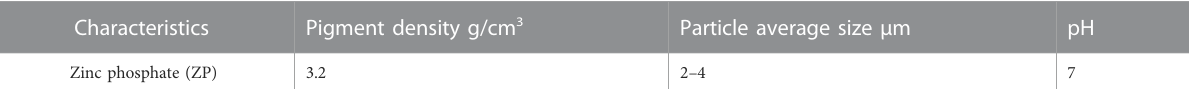
TABLE 1 Technical data of ZP pigments used for anti-corrosion coating.